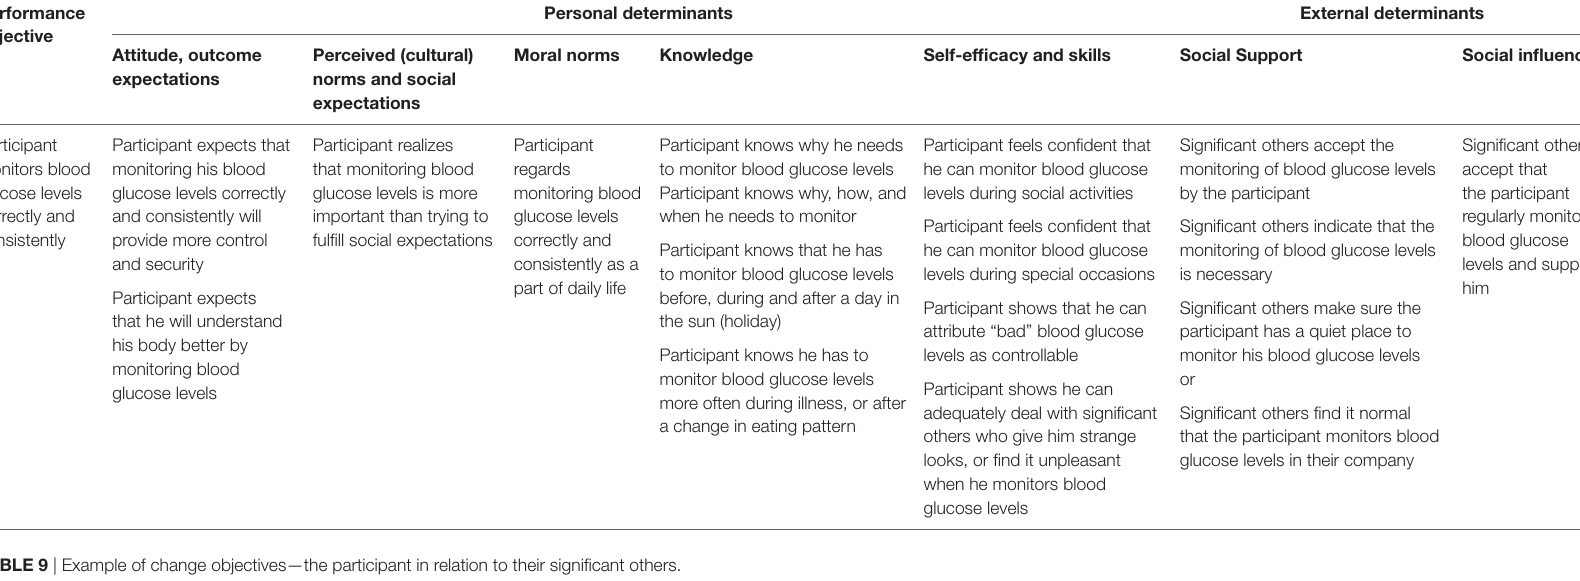
TaBle 9 | Example of change objectives—the participant in relation to their significant others. Performance